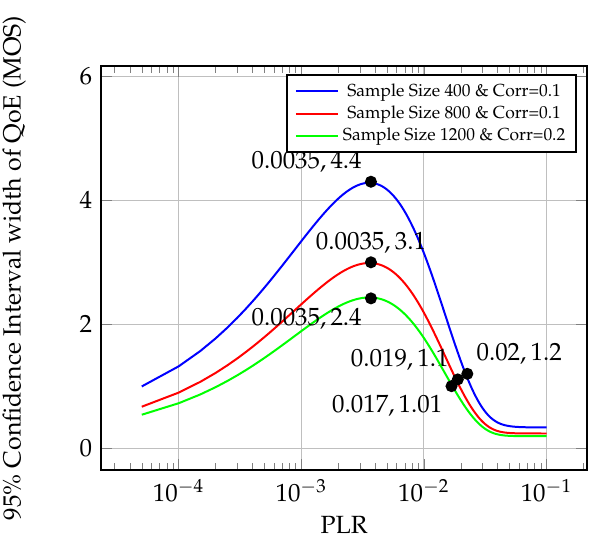
Figure 4. Propagated uncertainty in QoE vs. PLP at jitter = 1 ms with correlation using jitter model [14].